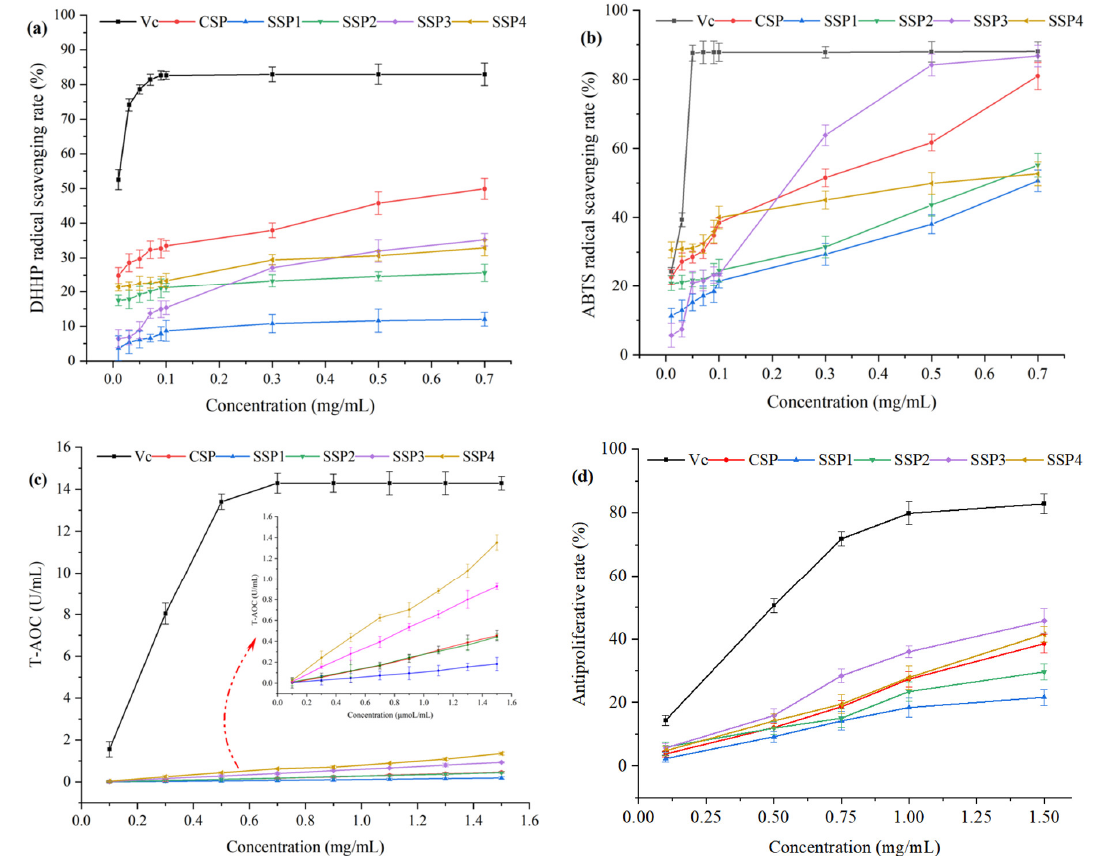
Figure 7. The physiological activities of SSPs. ( a ) DPPH assay, ( b ) ABTS assay, ( c ) T-AOC assay, ( d ) Antiproliferative activity.